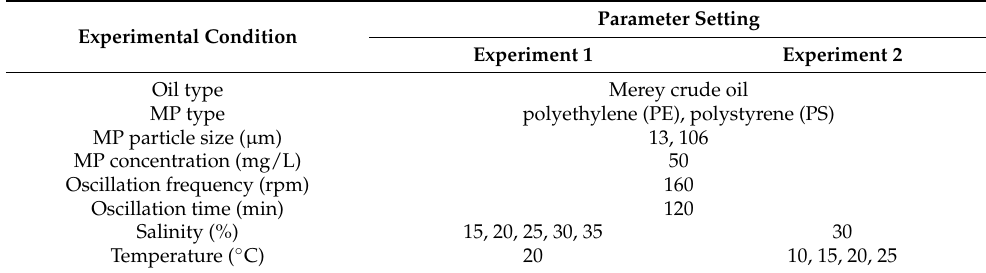
Table 2. Conditions and parameters for the laboratory